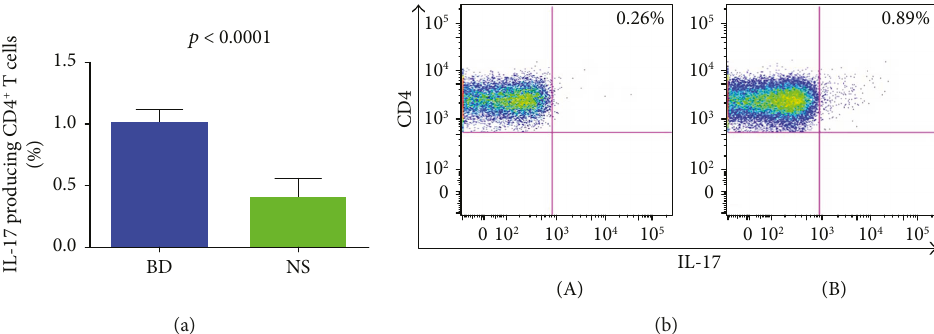
Figure 5: Flow cytometric analysis of CD4 + T cells releasing IL-17 in patients with BD. Panel (a) displays the mean percentage of CD4 + T cells releasing IL-17 of 30 healthy donors and 30 BD patients. PBMCs were stimulated over night with anti-CD3/CD28-coated beads. Panel (b) shows a representative experiment ((A) normal subjects (NS); (B) BD